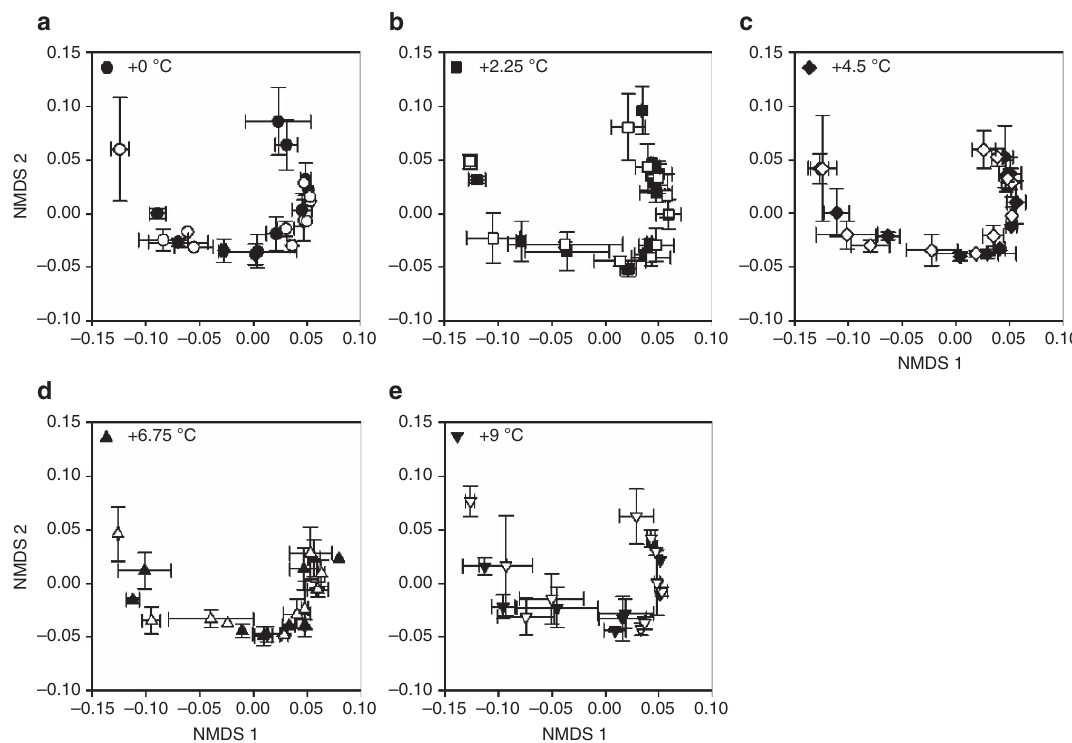
Figure 7 | Microbial community structure in treatment plots. Characterization of in situ microbial community structure by non-metric multidimensional scaling (NMDS) in ( a ) control plots, ( b ) þ 2.25 (cid:2) C plots, ( c ) þ 4.5 (cid:2) C plots, ( d ) þ 6.75 (cid:2) C plots and ( e ) þ 9 (cid:2) C plots. Symbols represent averages of two samples collected from each plot/depth within each temperature treatment plot from pre-DPH (2014, closed symbols) and 13 months post-initiation of the DPH (2015, open symbols) experiment. Error bars represent 1 s.d. of replicate results. Circles represent results from the control (0 (cid:2) C) plots, squares represent results from the þ 2.25 (cid:2) C plots, diamonds represent results from the þ 4.5 (cid:2) C plots, triangles represent results from the þ 6.75 (cid:2) C plots, and inverted triangles represent results from the þ 9 (cid:2) C plots. Final sequence data were normalized by cumulative sum scaling (CSS) and beta diversity indices were estimated based on Bray–Curtis and weighted as well as unweighted Unifrac distances. Significant differences in beta diversity were analysed by a PERMANOVA test on weighted Unifrac distance metrics with 1,000 permutations followed by Bonferroni correction of P